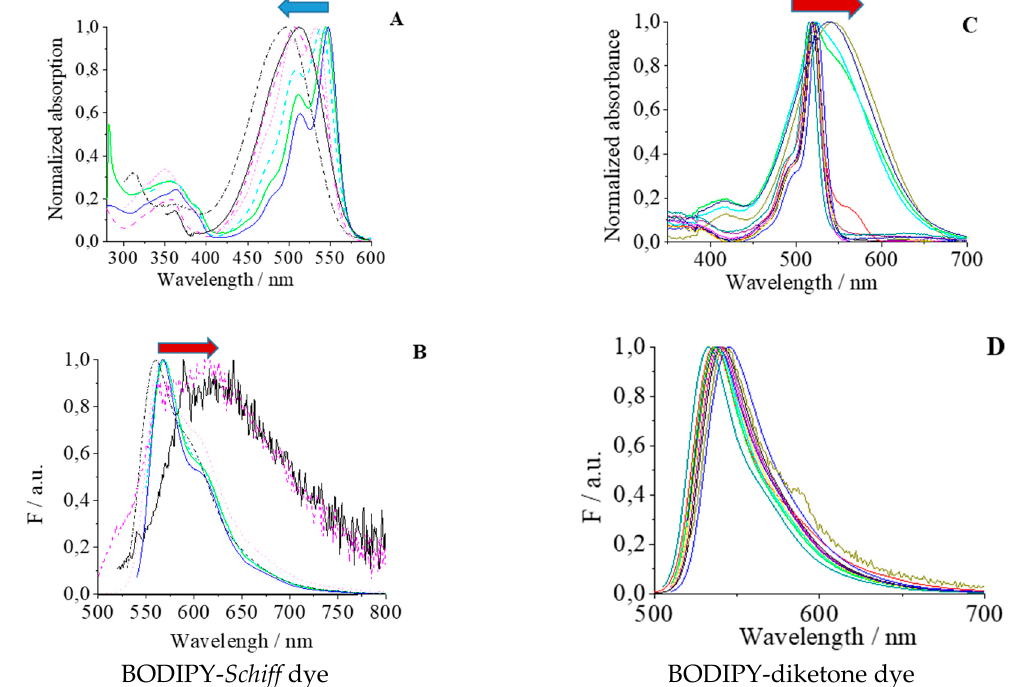
Figure 20. The selected absorption ( A , C ) and emission ( B , D ) spectra of BODIPY- Schiff and BODIPY-diketone dyes, respectively, in variations of solvents. The list of solvents is presented in Refs. [87,88]. Adapted from Refs. [87,88]. Copyright 2015 and 2018, The American Chemical Society.